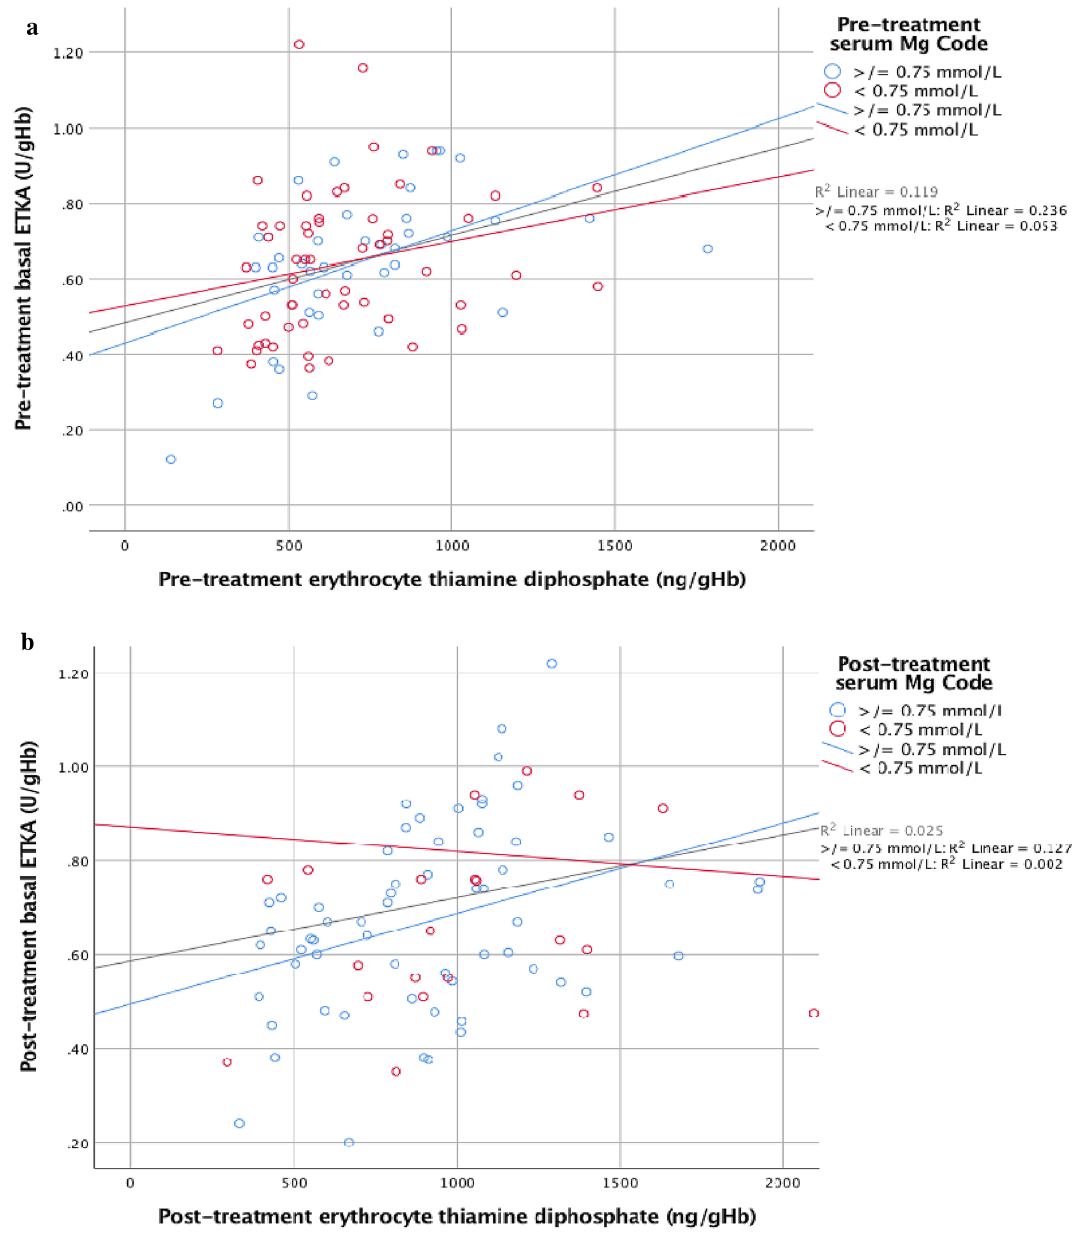
Figure 5. ( a ) Pre-treatment basal ETKA versus pre-treatment erythrocyte TDP with pre-treatment magnesium status highlighted (n = 97), ( b ) Post-treatment basal ETKA versus post treatment erythrocyte TDP with post- treatment magnesium status highlighted (n =